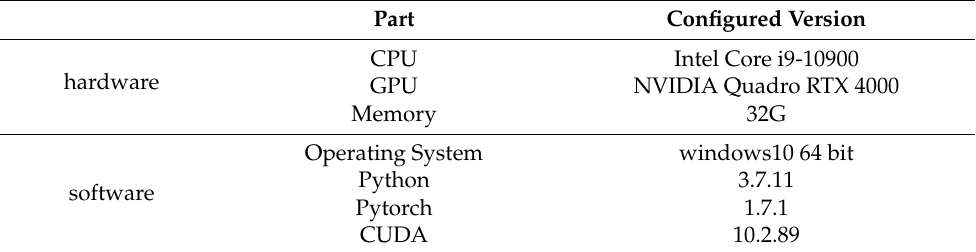
Table 3. Experimental environment description.